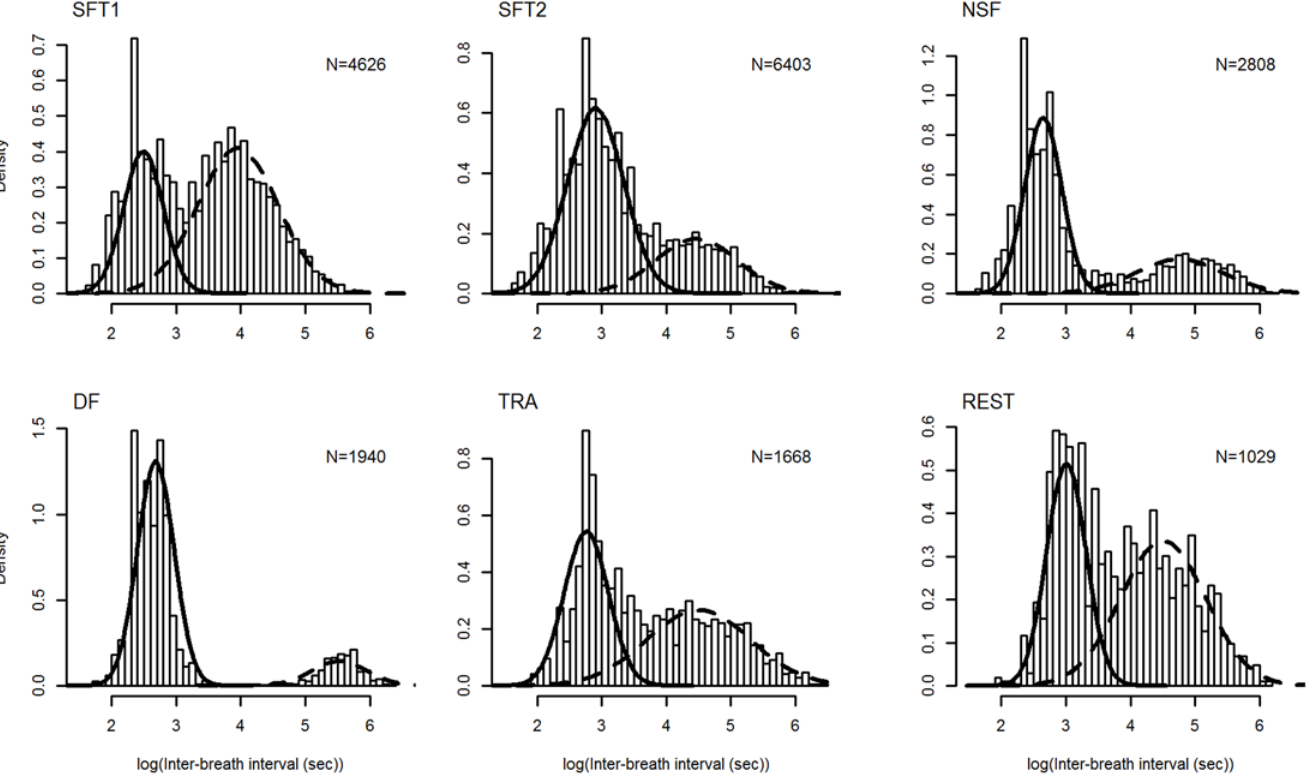
Fig 2. Density distribution of logged IBI for minke whales during different activity states. SFT1 = surface feeding tactic I, SFT2 = surface feeding tactic II, NSF = near-surface foraging, DF = deep foraging, TRA = traveling, REST = resting. The solid and dashed lines represent the density distributions of short dives and long dives, respectively. The sample size (N) for each activity state is shown at upper right corner of each subfigure.